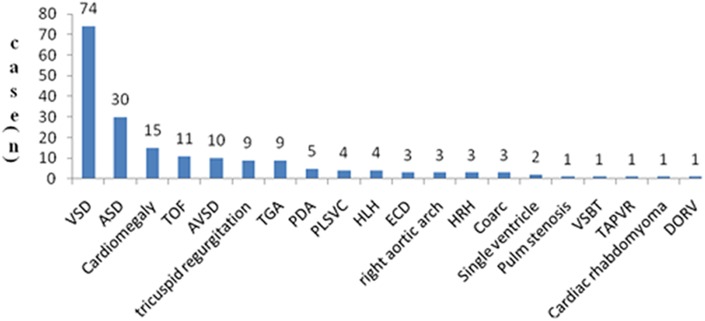
Spectrum of CHDs in a non-selected population of 53313 PIs.The most severe types of CHDs were defined as those in which several types of CHDs occurred simultaneously. VSD: ventricular septal defect; ASD: atrial septal defect; TOF: tetralogy of Fallot; AVSD: atrioventricular septal defect; TGA: transposition of the great arteries; PDA: patent ductus arteriosus; PLSVC: persistent left superior vena cava; HLHS: hypoplastic left heart; ECD: endocardial cushion defect; HRHS: hypoplastic right heart; Coarc: coarctation of the aorta; VSBT: ventricular septal bulging tumor; TAPVR: total anomalous pulmonary venous return; DORV: double-outlet right ventricle; cardiomegaly: major characteristics of cardiomegaly without specific diagnosis.